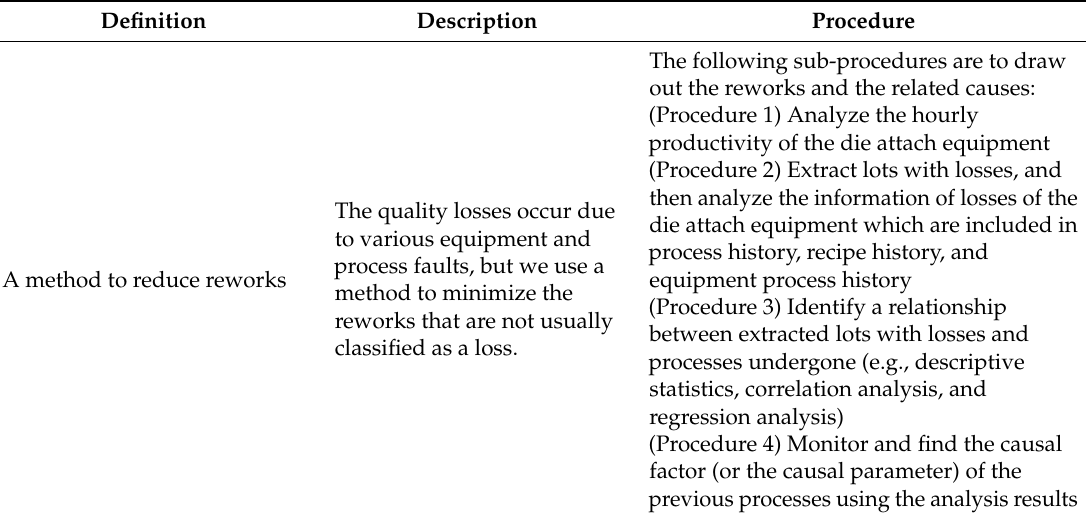
Table 4. Development method 2 of a new monitoring